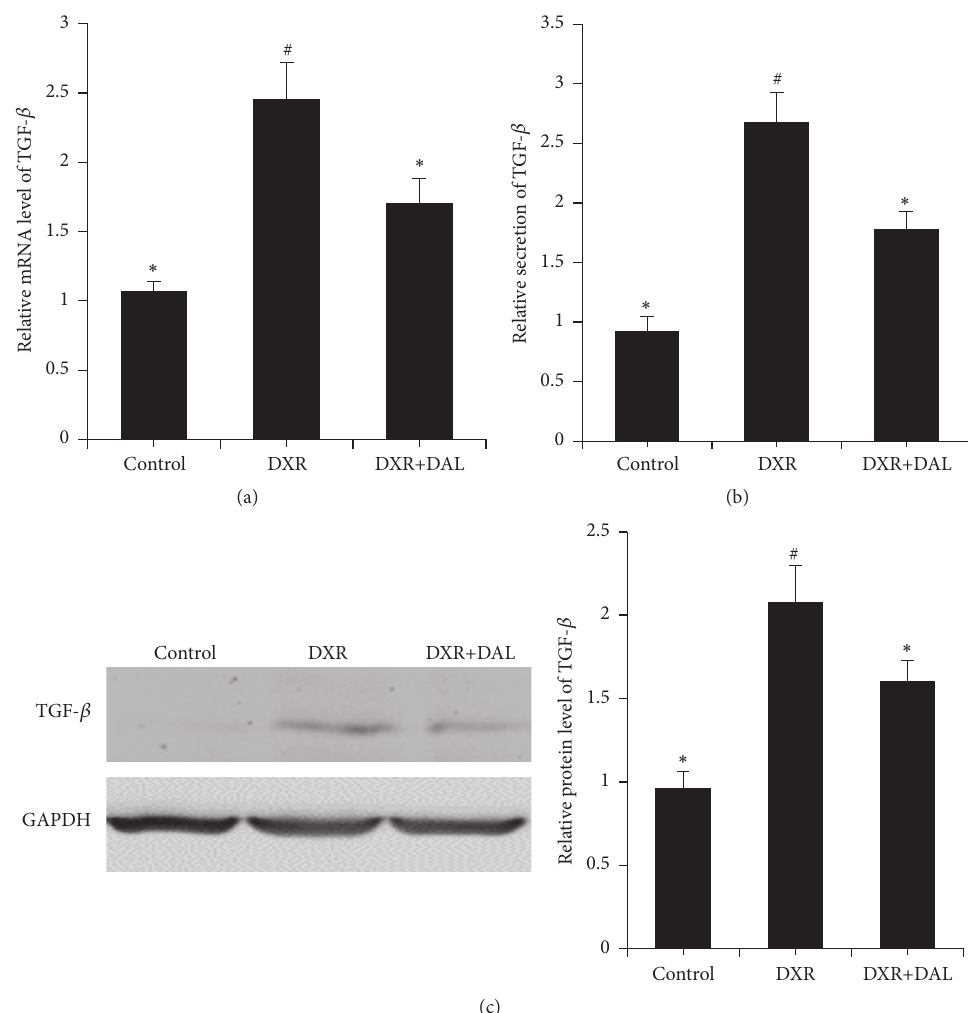
Figure 6: The expression of TGF- 𝛽 in kidney tissue 5 weeks after DXR injection in different groups of mice as indicated. (a) DAL decreases the gene expression of TGF- 𝛽 ; (b) DAL decreases the protein expression of TGF- 𝛽 by ELISA; (c) DAL decreases the protein expression of TGF- 𝛽 as determined by western blotting. The control and DAL treatment groups are compared with the DXR group. Values are statistically significant at ∗ 𝑝 < 0.05 ; the DXR group is compared with the control group. Values are statistically significant at # 𝑝 < 0.05